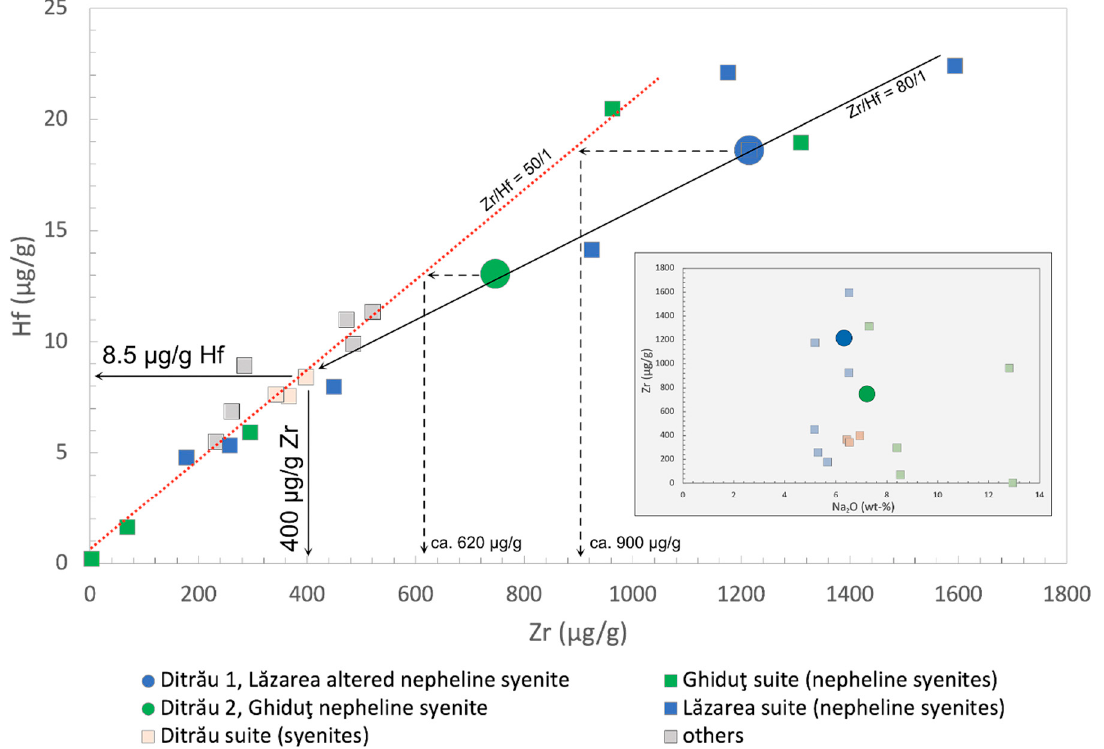
Figure 4. Zr-Hf whole-rock systematics of the DAM intrusives. The red dashed line refers to the average Zr/Hf ratio of the DAM syenites and nepheline syenites showing different degrees of metasomatic/hydrothermal alteration. The two samples Ditr ă u 1 and 2 evidently lie off this reference line, indicating a metasomatic/hydrothermal agent relatively enriched in Zr, resulting in a model Zr/Hf ratio of ca. 80 (black arrow). The dashed and full black arrows indicate endmember Zr and Hf concentrations derived from different petrogenetic models. The inset shows the Na 2 O versus Zr systematics of the DAM alkaline rocks, demonstrating that there is no correlation of Na 2 O with Zr. See text for further discussion. Symbols are as in Figure 3a with the exception of "others" which designates literature data from hornblendites, the S ă rma ș gabbro, the Bear Valley mafic syenite, and the Hagota quartz syenite. Literature data are from [17,23].